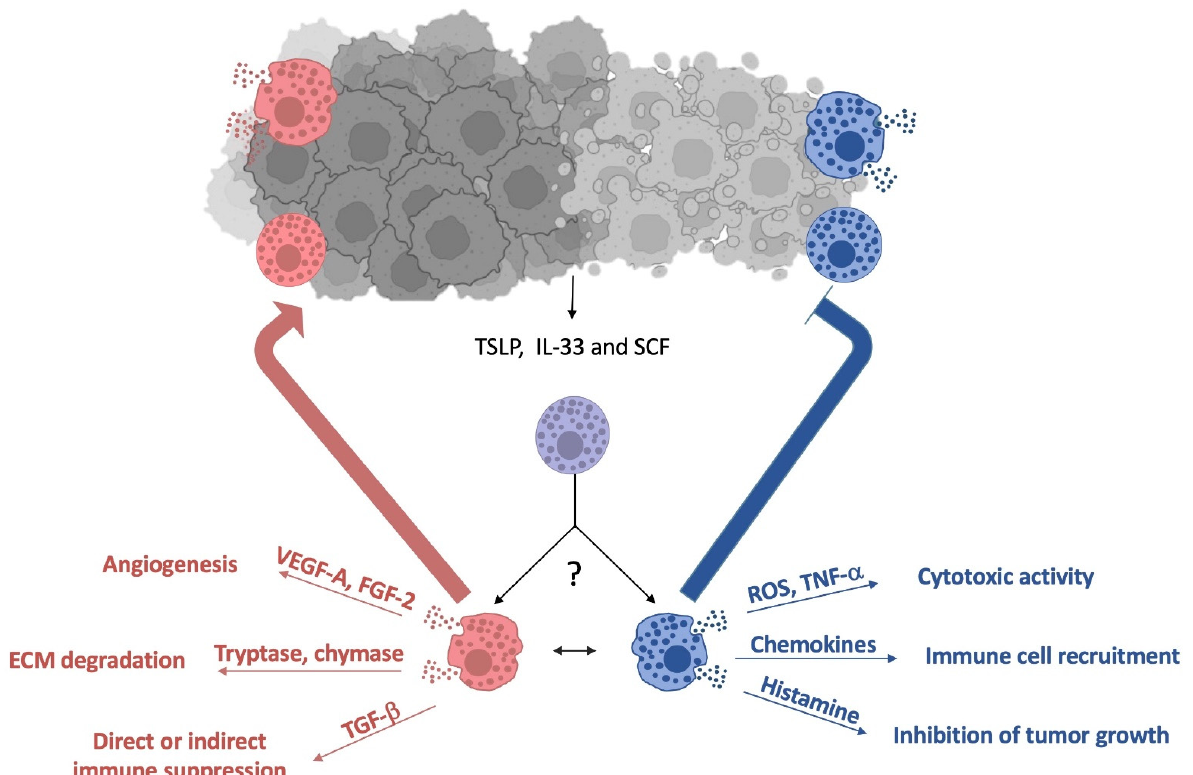
Figure 2. The dichotomous role of MCs during CRC. MCs infiltrating colonic tumor can directly interact with cancer cells or recognize tumor-released factors, such TSLP, IL-33 and SCF, tuning their phenotype/activity. Different MC subsets can exert either pro-tumorigenic (red arrow) or anti-tumorigenic (blue arrow) properties through the secretion of preformed and newly synthesized mediators, the main of which are depicted. TSLP: thymic stromal lymphopoietin; IL-33: Interleukin- 33, SCF: stem cell factor, VEGF: vascular endothelial growth factor; FGF: fibroblast growth factor, TGF: transforming growth factor, ROS: reactive oxygen species, TNF: tumor necrosis